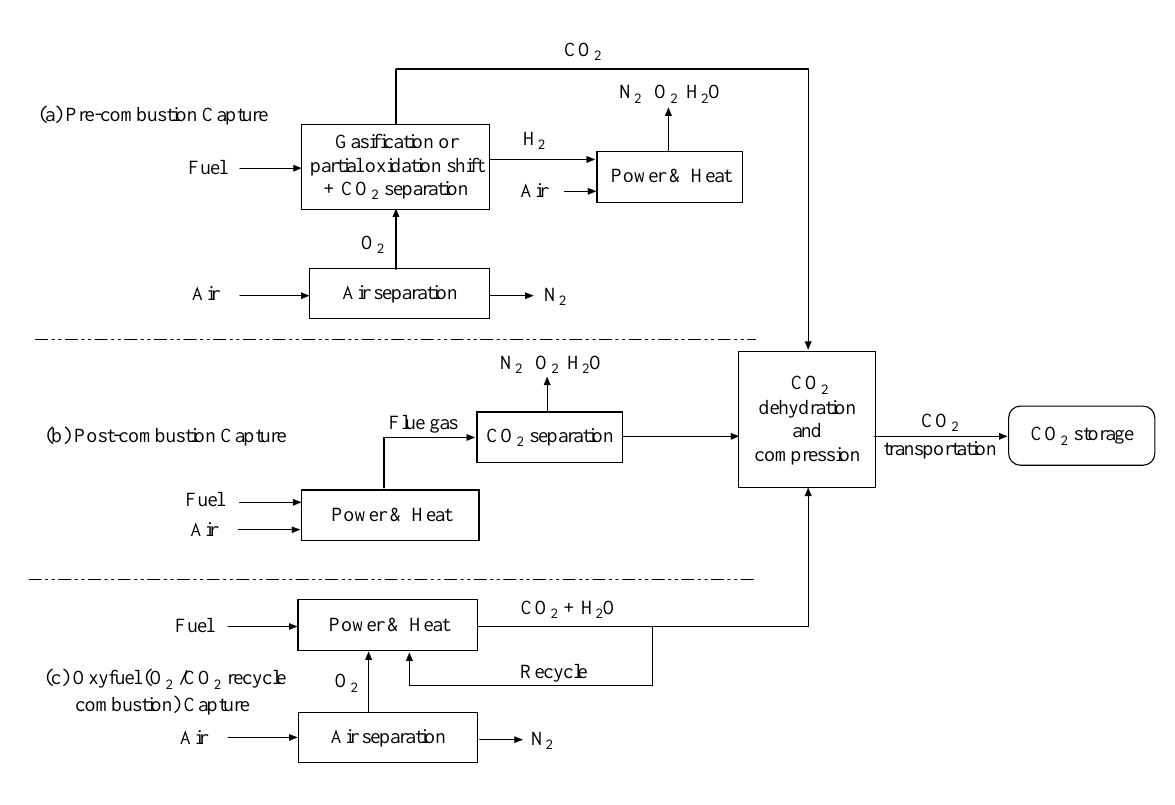
Figure 7. Three main technological trajectories on CCSTP competition.